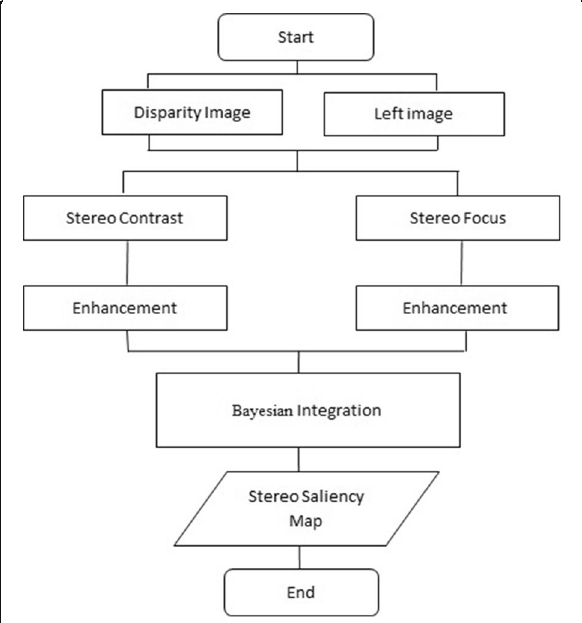
Fig. 3 The framework of the proposed stereo saliency